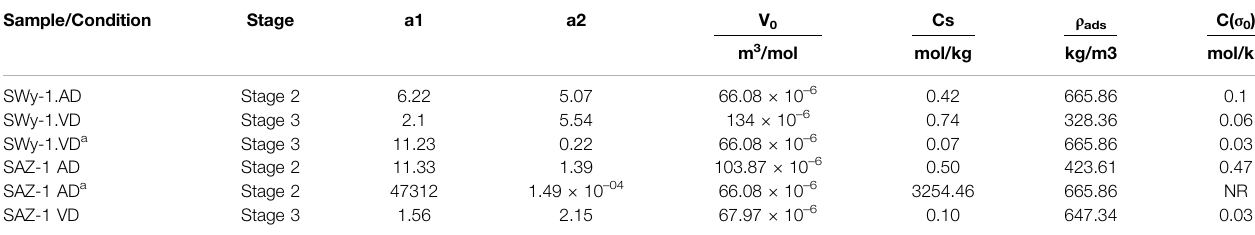
TABLE 3 | Parameter values obtained from best fi t of Hol-Liu-Spiers Model ( Eq. 2 ) to our data for samples exposed to CO 2 relative to He and/or Ar. Sample/Condition